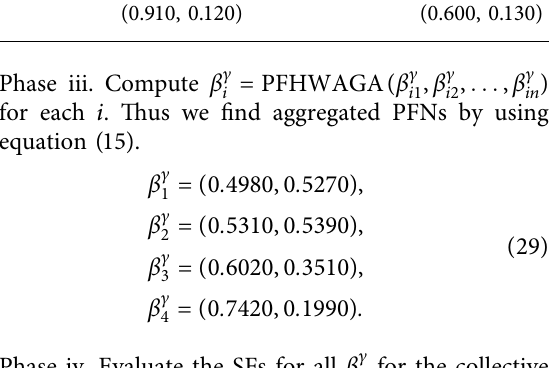
Phase iv. Evaluate the SFs for all β c overall PFNs.